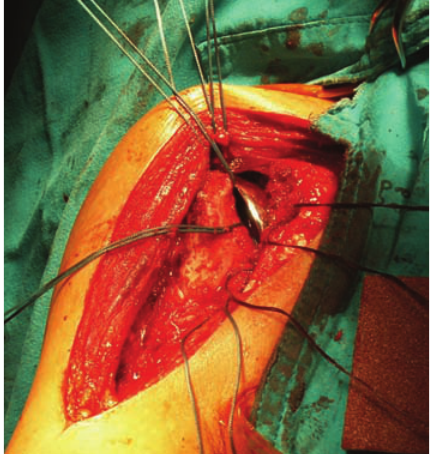
Figure 3: Immediate cementless stem humeral head arthroplasty was